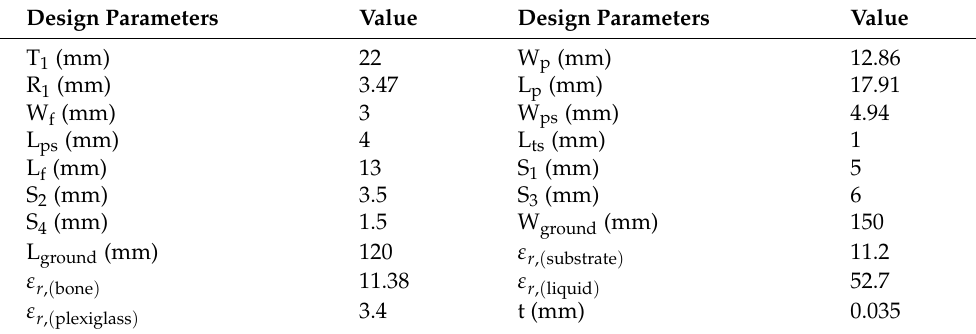
Figure 3. Regression DNN for predicting the best design parameters of implanted MIMO antenna. Table 1. Design parameters of optimized implanted MIMO antenna in Figure